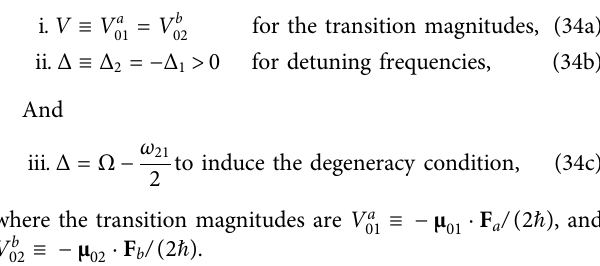
FIGURE 11 | (A) Geometrical structure of toluene molecule (C S ) in the ground state (S 0 ) with the directions of the two electronic transition dipole moments; (B) Parameters for the three electronic states adopted to induce the unidirectional angular momentum: Z ω S μ (cid:2) 5 . 27 D, and μ (cid:2) 5 . 67 D as the transition dipole moments, E S 3 S 0 , X S 4 S 0 , Y (cid:2) 0 . 672 i , is perpendicular to the aromatic element between S 3 and S 4 , ℓ Z , S 3 S 4